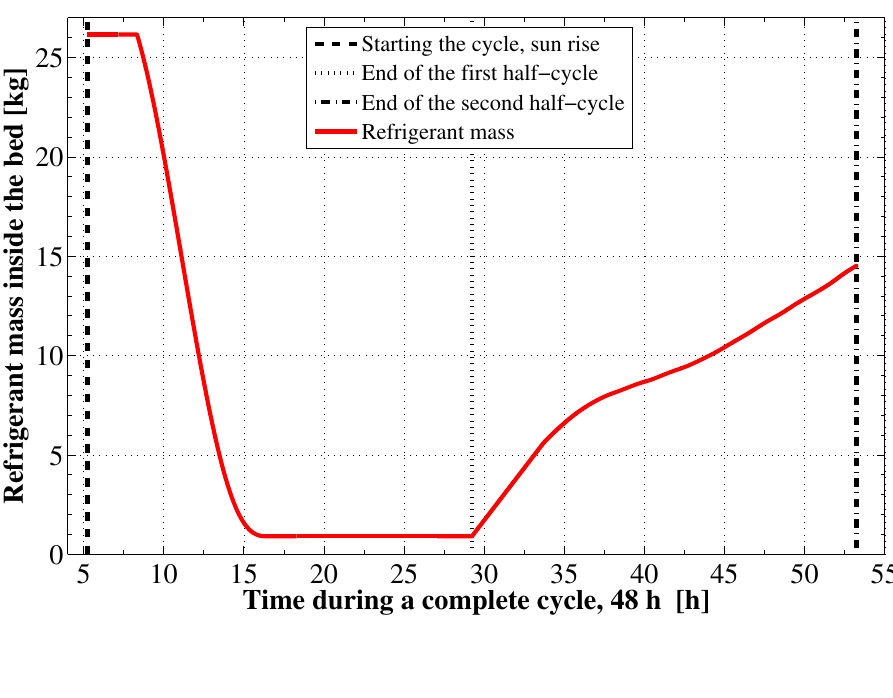
Figure 6. Development of the refrigerant mass inside the bed.